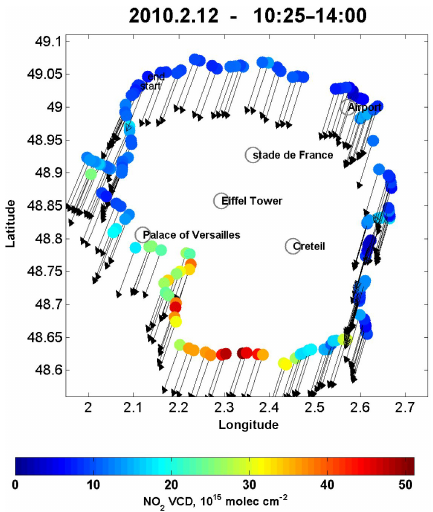
Figure 1. Tropospheric vertical column densities (VCDs) of NO 2 derived from car MAX-DOAS measurements around Paris on 12 February 2010 (each dot indicates an individual measurement). The arrows indicate wind speed and direction taken from the regional CHIMERE model. The average wind speed was about 8.5ms − 1 .